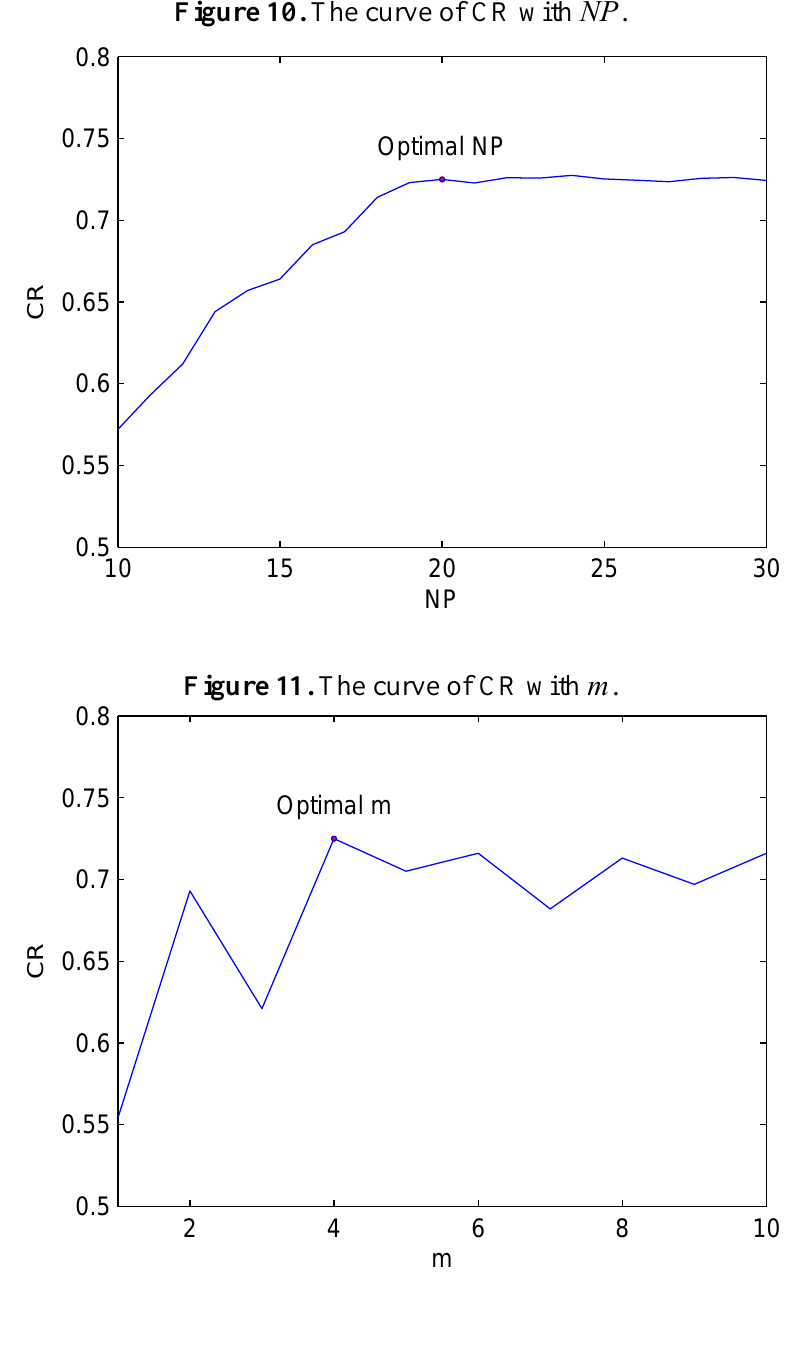
Figure 10. The curve of CR with NP .